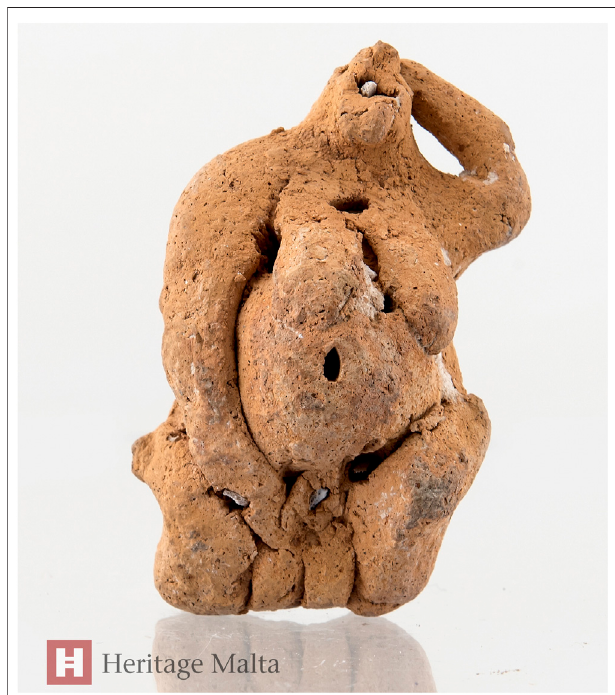
FIGURE 13 | Unusual clay fi gurine from Tarxien temple, which has had smallpieces ofshellpushed into itbefore fi ring. The location ofthesein places associated with key points of the lymphatic system may suggest a link to diseases such as the plague (Image provided by Heritage Malta. Copyright image not to be reused without permission of Heritage